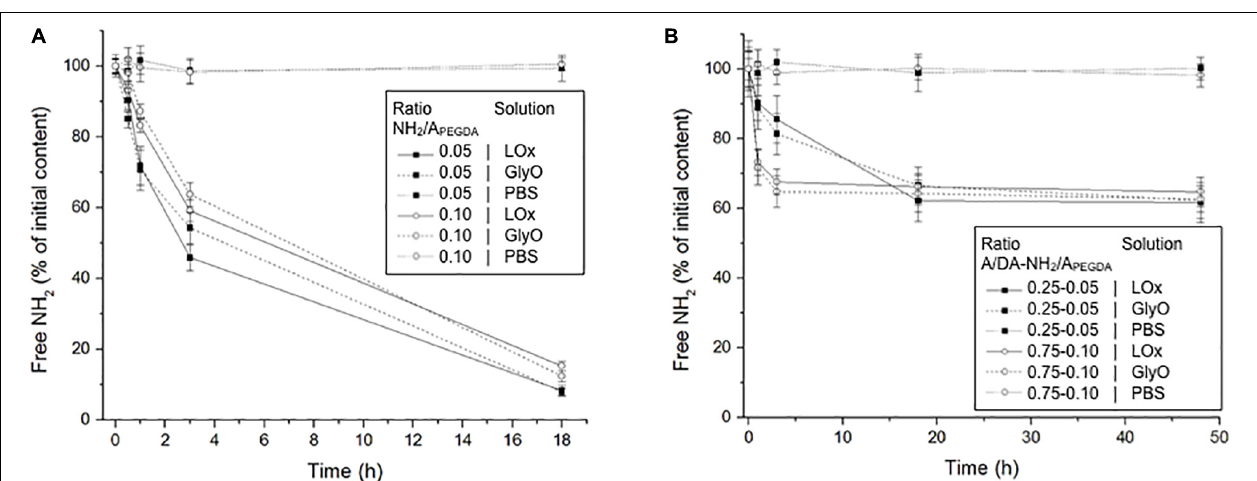
FIGURE 4 | (A) Free amino content measured over time for both the 0.75 to 0.05 (black squares) and the 0.75 to 0.10 (white circles) A/DA-NH 2 /A PEGDA soluble models incubated with LOx, GlyO (positive control) and PBS (negative control). (B) Free amino content measured over time for both the 0.25 to 0.05 (black squares) and the 0.75 to 0.10 (white circles) A/DA-NH 2 /A PEGDA crosslinked hydrogels incubated with LOx, GlyO or PBS. Each free amine time series was analyzed independently and found statistically different (one-way ANOVA, p <